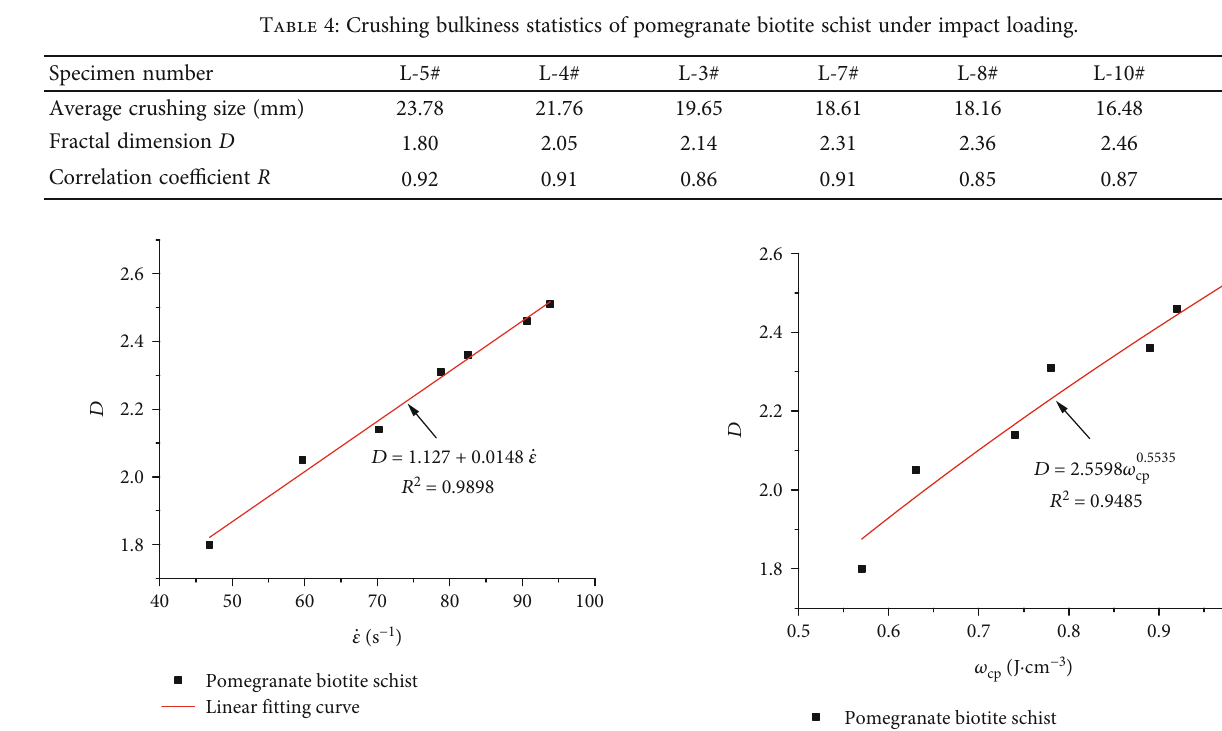
Figure 7: Fractal dimension versus strain rate for pomegranate biotite schist.